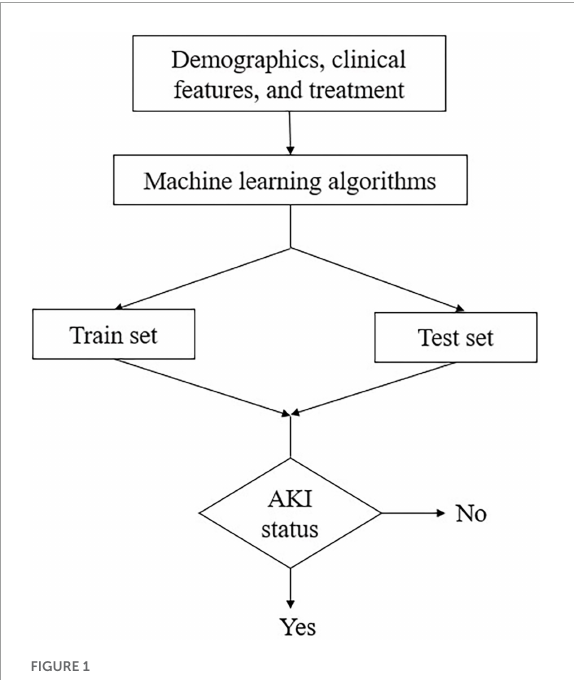
FIGURE1 Process of establishing the prediction model. AKI, acute kidney